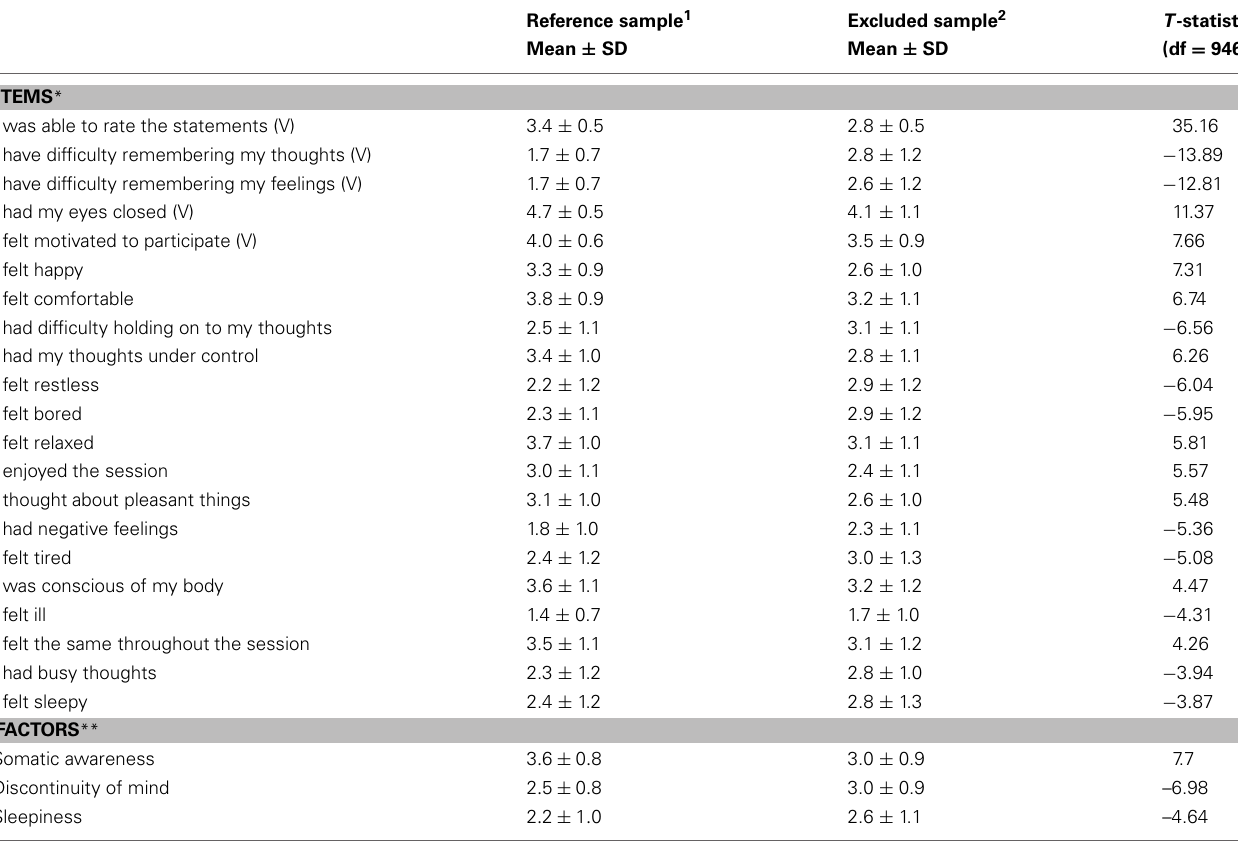
Table 5 | Participants excluded for indicating inability to rate the ARSQ primarily differ on items that are used for validation (V) and those related to Discontinuity of Mind, Sleepiness and Somatic